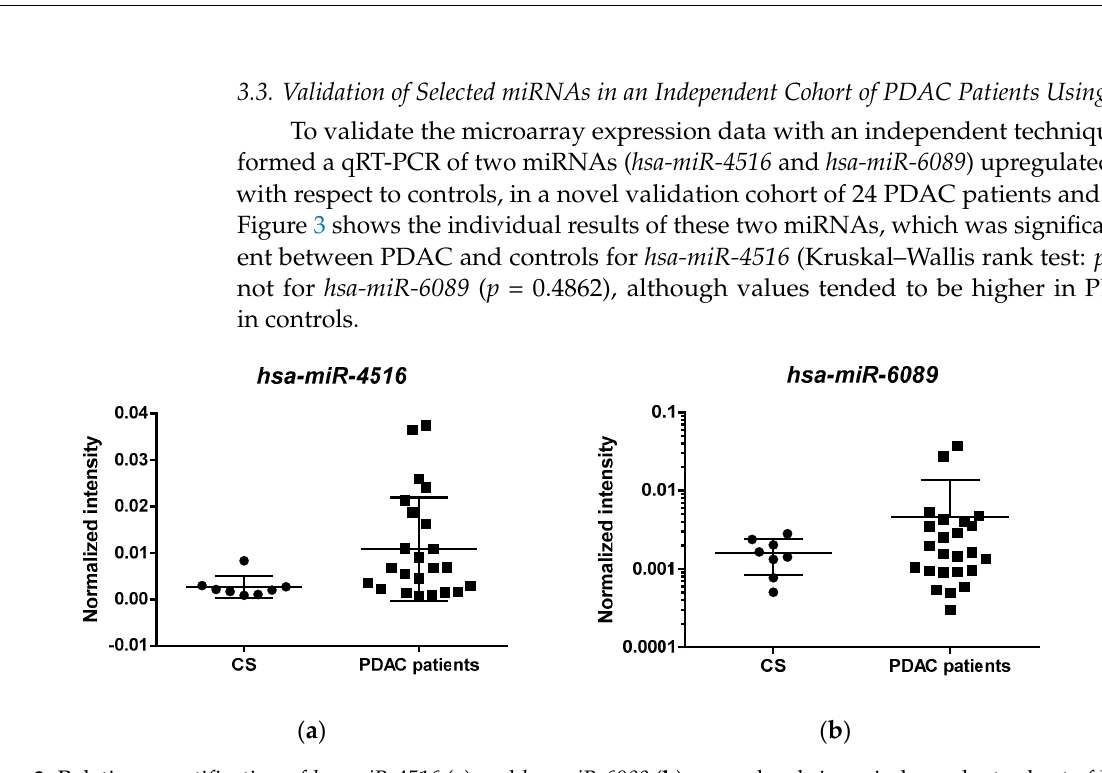
Figure 3. Relative quantification of hsa - miR-4516 ( a ) and hsa - miR-6089 ( b ) serum levels in an independent cohort of PDAC patients. The relative serum expression levels of hsa - miR-4516 and hsa - miR-6089 measured in 8 controls (CS) and in 24 PDAC patients are shown.